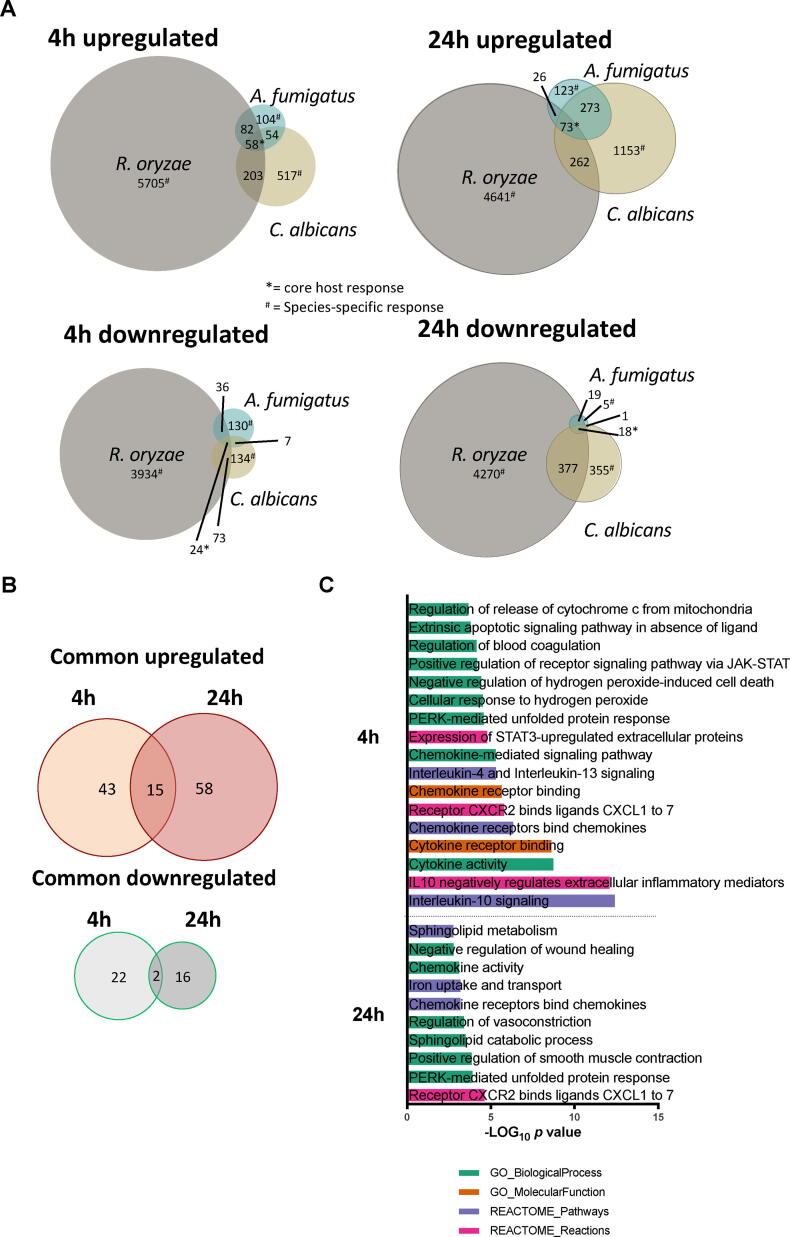
Common transcriptional response to A. fumigatus, C. albicans and R. oryzae (A) Proportional VENN diagrams of differentially regulated RNA transcripts from the RNA-Seq dataset (corrected p-values < 0.05 and a Log2FC > 0.9 for up-regulated and < -0.9 for down-regulated; see methods) and their overlap in PBMCs stimulated with A. fumigatus, C. albicans or R. oryzae after 4 h (left) or 24 h (right). (B) Proportional VENN diagram representing the temporal distribution of RNA transcripts that are commonly regulated in PBMCs following stimulation by all of the three fungi A. fumigatus, C. albicans or R. oryzae and represent the “core” host response. (C) Enriched pathways within the set of commonly differentially regulated genes plotted as the -Log10 of the p-value after Benjamini-Hochberg correction.